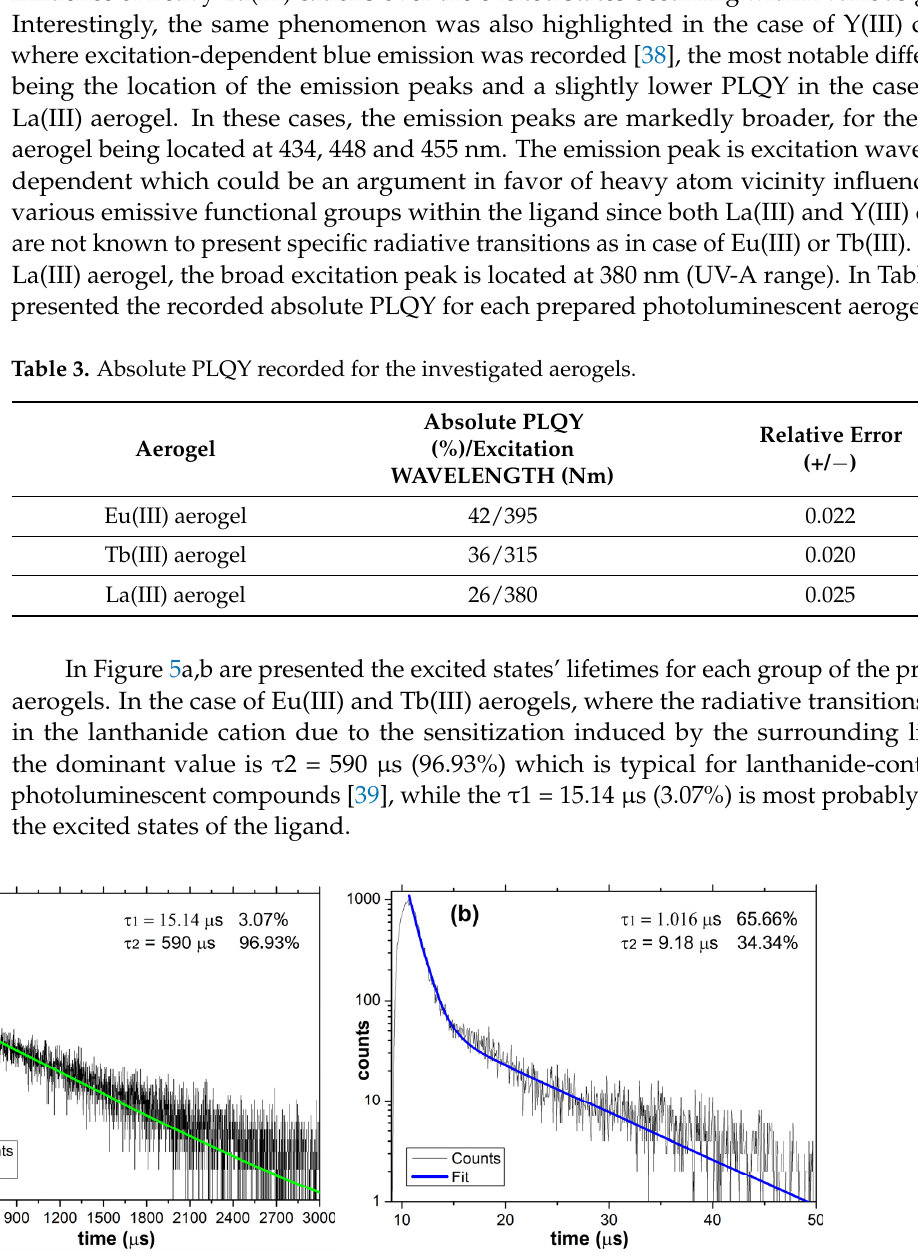
Figure 5. Luminescence lifetimes were recorded for the ( a ) Tb(III) aerogel and ( b ) La(III) aerogel